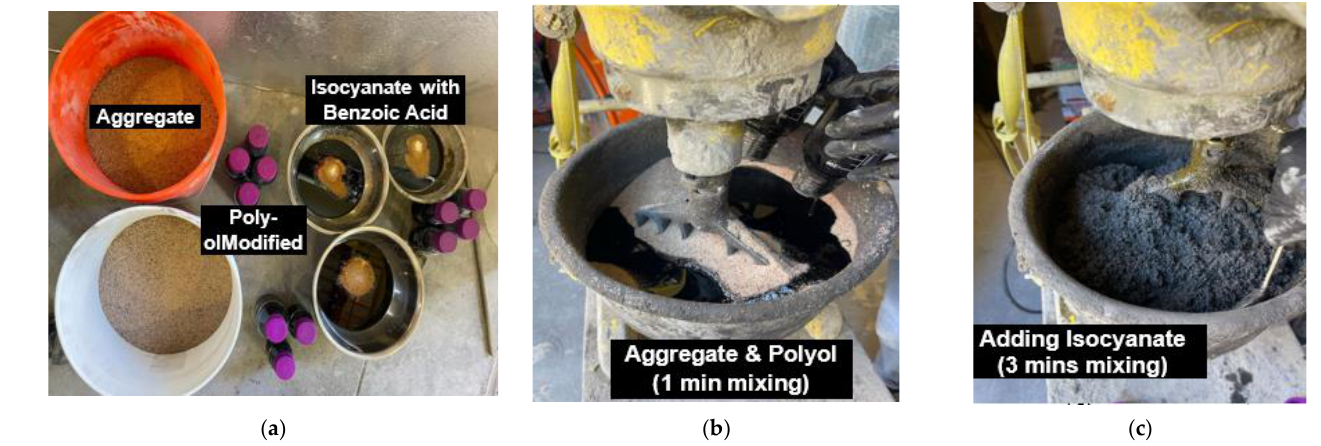
Figure 2. Mixing of BPC. Steps shown from left to right: ( a ) ingredients, ( b ) step 1 mixing, and ( c ) step 2 mixing.